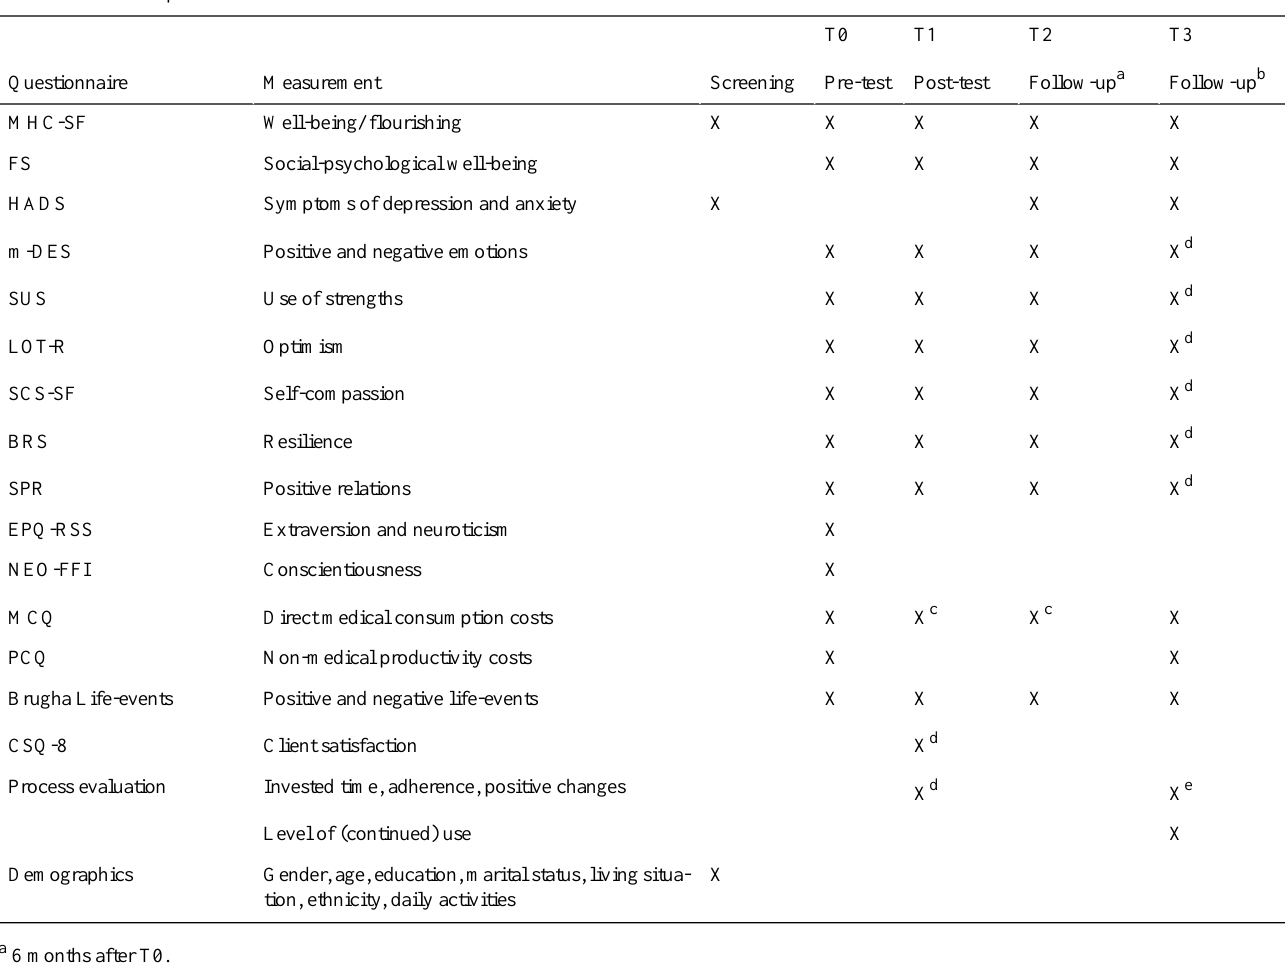
Table 2. Intended questionnaires and assessment